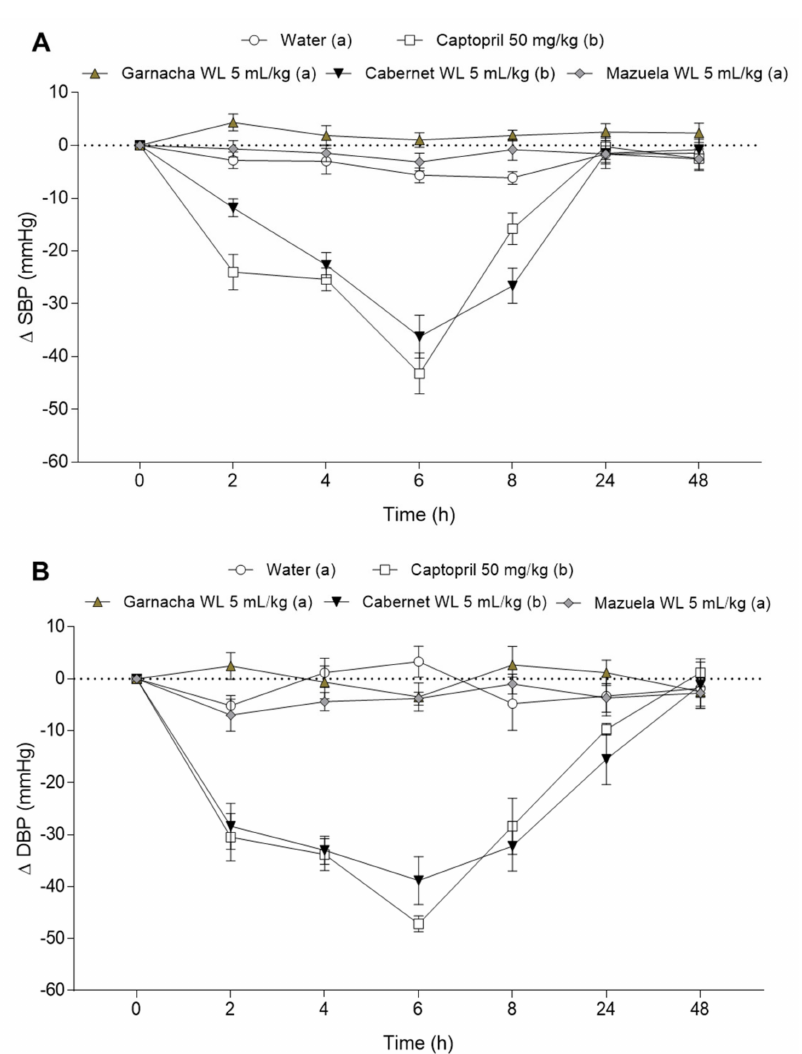
Figure 4. Decrease of systolic blood pressure (SBP, A ) and diastolic blood pressure (DBP, B ) in spontaneous hypertensive rats after the administration of water, Captopril (50 mg/kg bw), and the three selected wine lees (WL; 5 mL/kg bw): Garnacha WL, Cabernet WL, and Mazuela WL. Data are expressed as mean ( n = 6) ± SEM. Significant differences ( p < 0.05) between treatments are represented by different letters in the legend. p value was estimated by two-way ANOVA and Tukey test was used as post